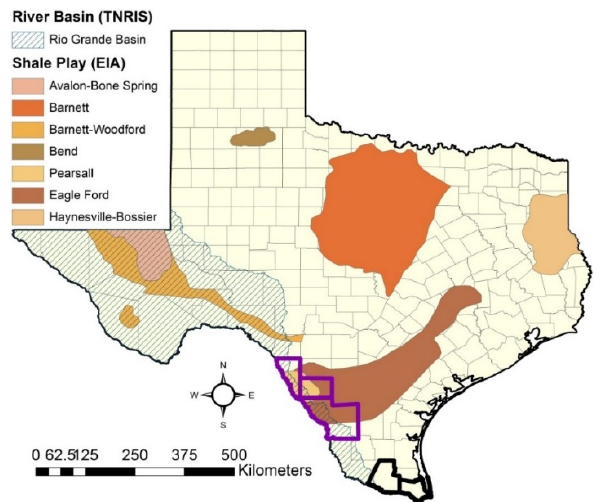
Figure 5. Two shale plays overlap with the Rio Grande River Basin, the Barnett-Woodford and Eagle Ford shales. Webb, Maverick, and Dimmitt counties are outlined in purple, and Cameron and Hidalgo counties are outlined in black. (Map created by the authors based on data from [21,22,29]).